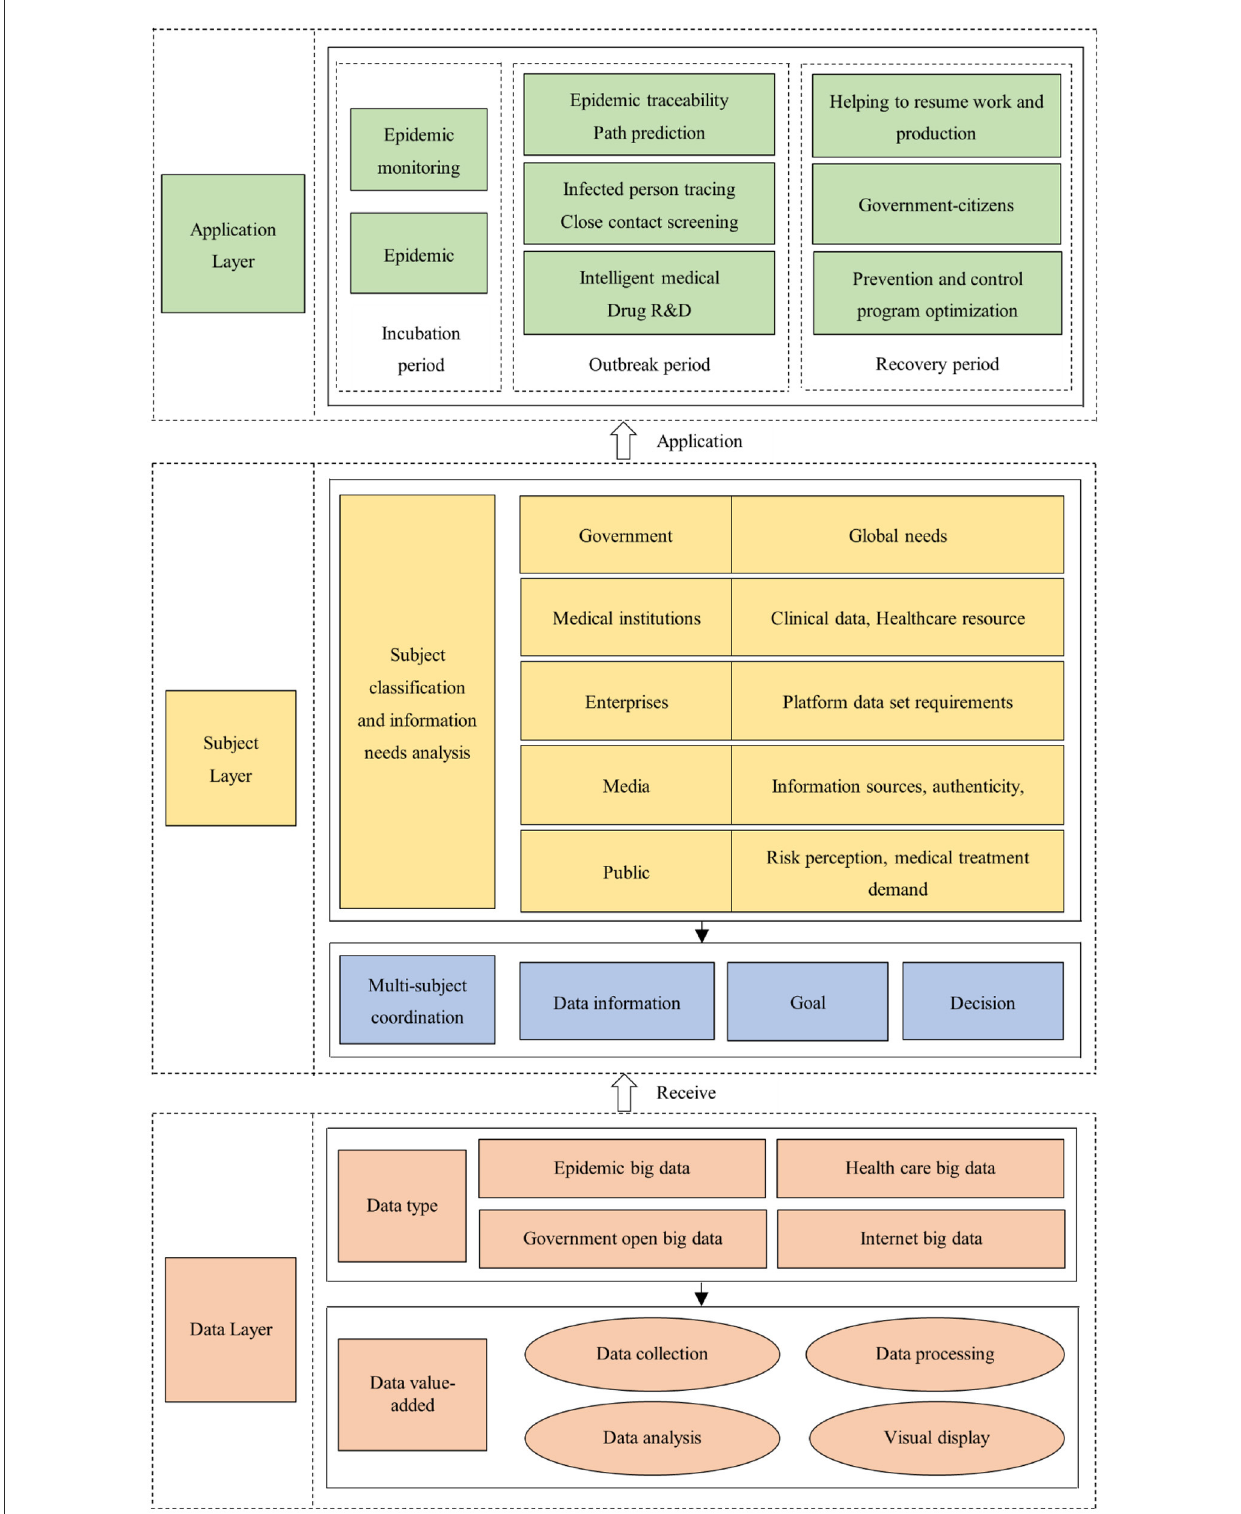
FIGURE3 The “DSA” model of big data prevention and control of public health